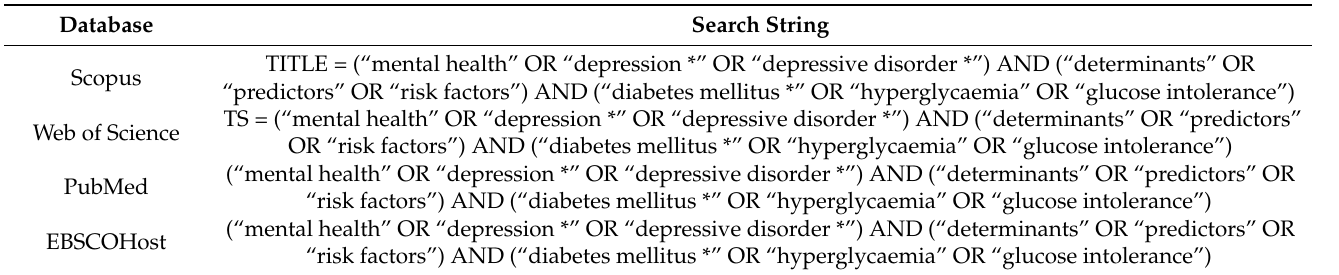
Table 1. Keyword search in the identification